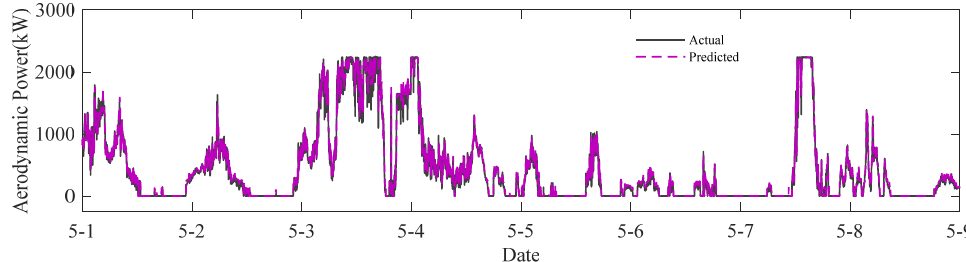
Figure 5. Prediction results of the aerodynamic power prediction model.